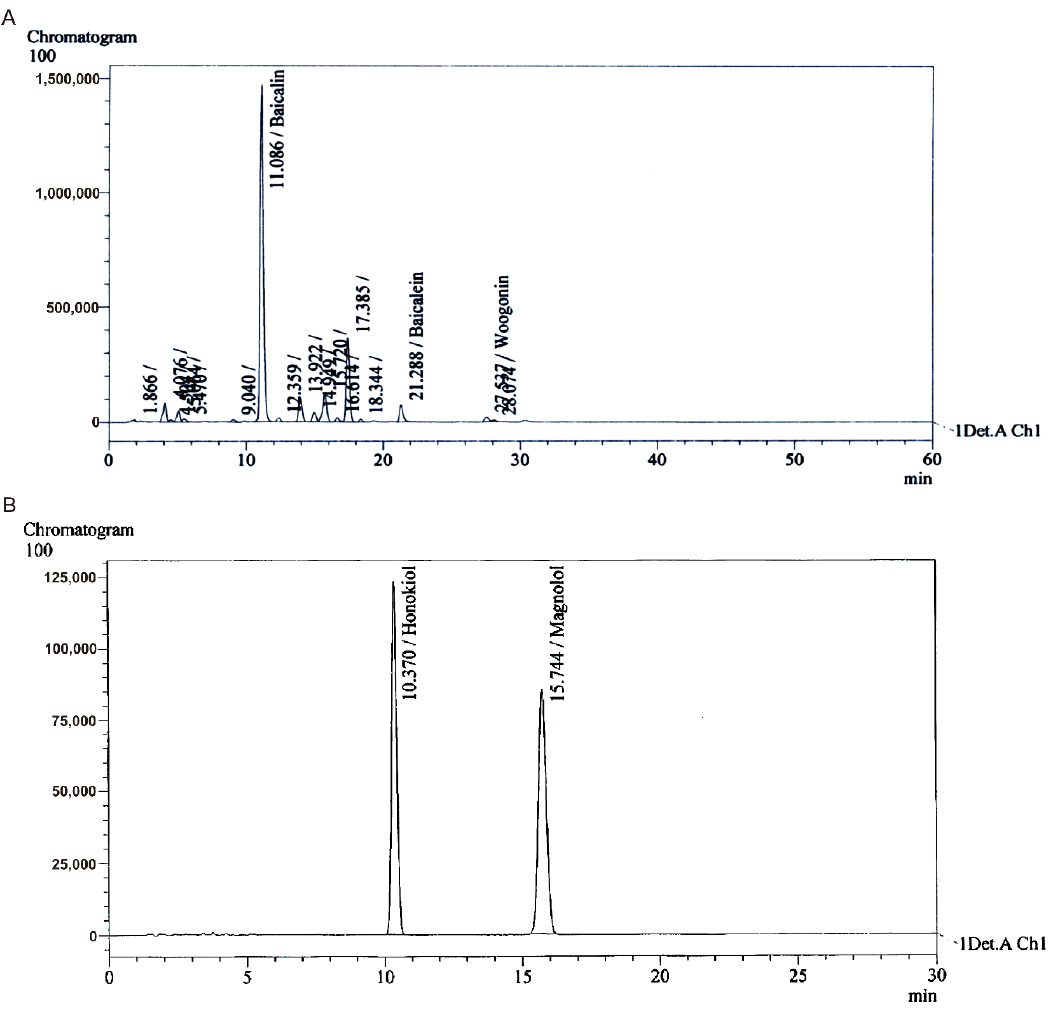
Figure 1. High-performance liquid chromatography of GenoTX-407. Peaks indicate baicalin existing in high proportion ( A ) and honokiol and magnolol existing in high proportion ( B ) in GenoTX-407.